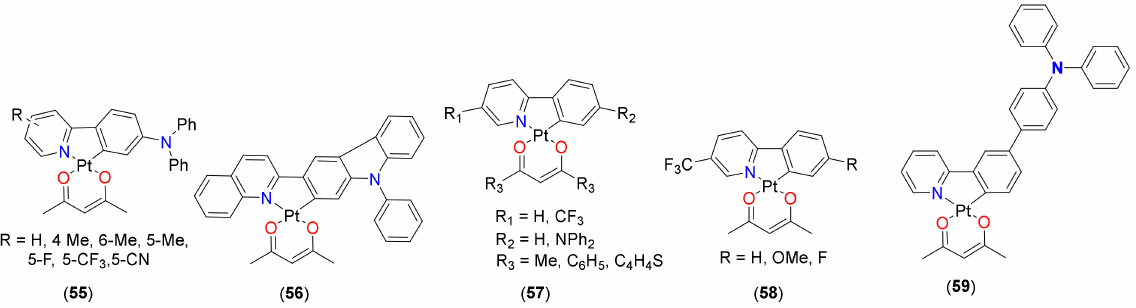
Figure 14. Cyclometalated Pt(II) complex-based oxygen